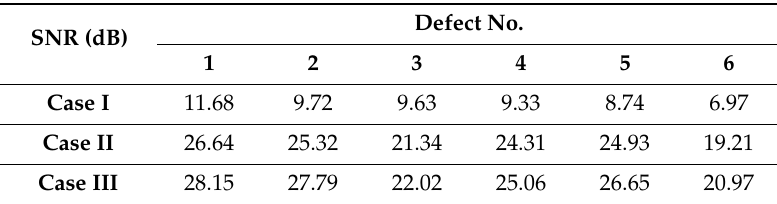
Table 2. Signal-to-noise ratio (SNR) of the hybrid full matrix for amplitude TFM ( I ), multiplied by IPWF ( II ) and IPCF ( III) .